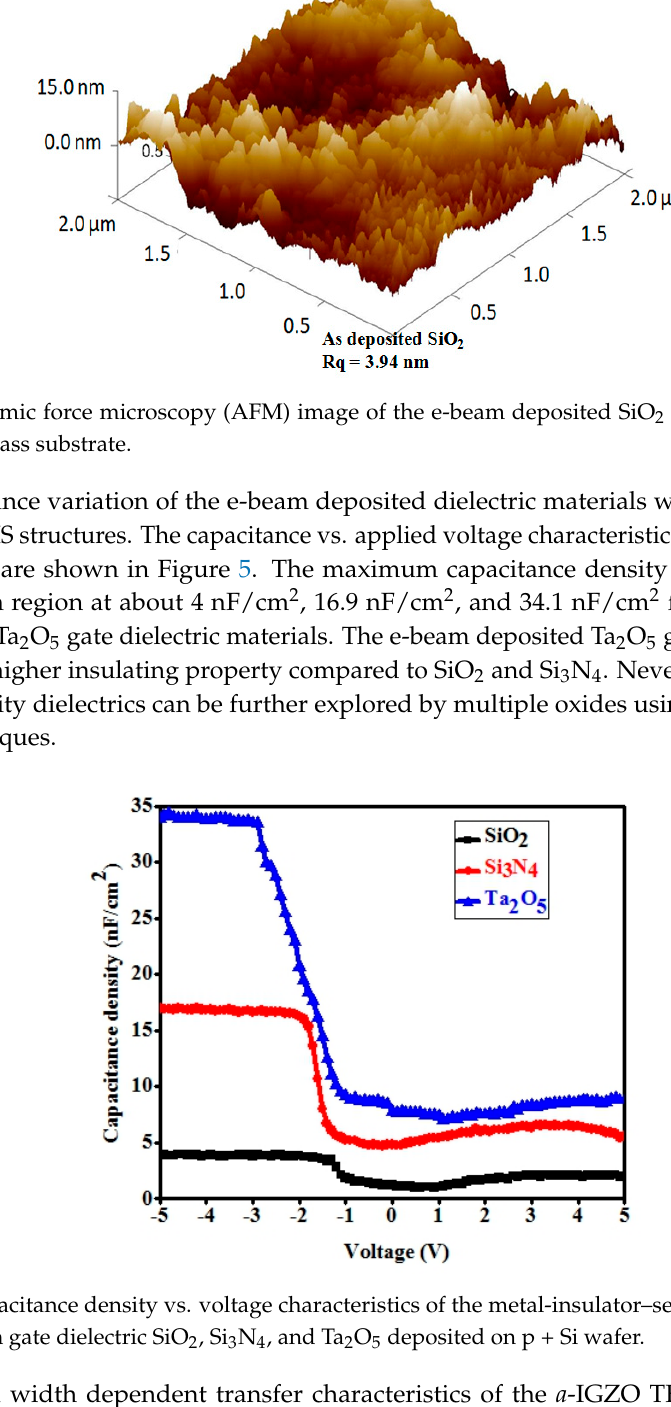
Figure 5. Capacitance density vs. voltage characteristics of the metal ‐ insulator–semiconductor (MIS) capacitor with gate dielectric SiO 2 , Si 3 N 4 , and Ta 2 O 5 deposited on p + Si wafer.